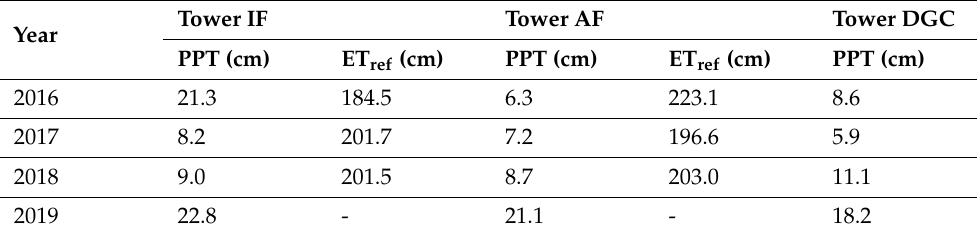
Table 1. Yearly Precipitation (PPT) and ET ref totals in cm based on tower